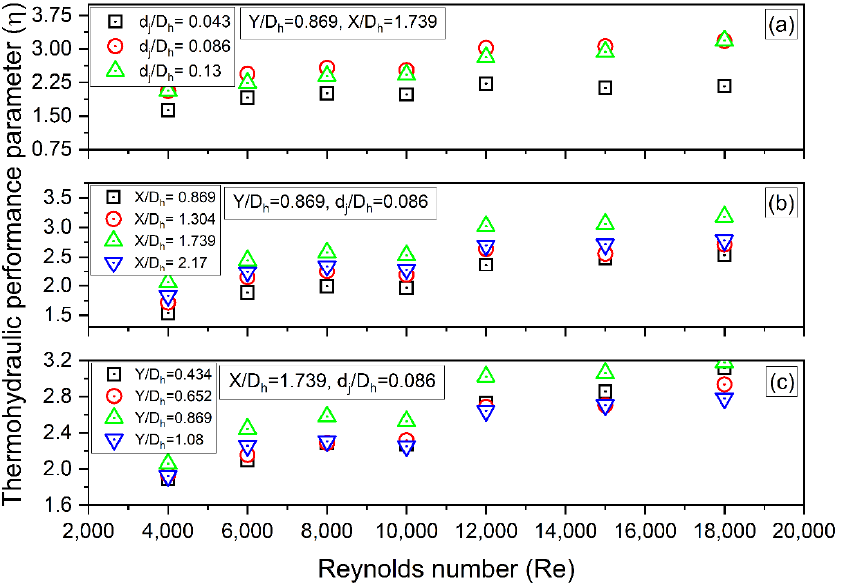
Figure 12. η variation with Re as a function of ( a ) d j / D h , ( b ) X / D h and ( c ) Y / D h Figure 12. i variation with (cid:8)(cid:9) as a function of ( a ) (cid:19)